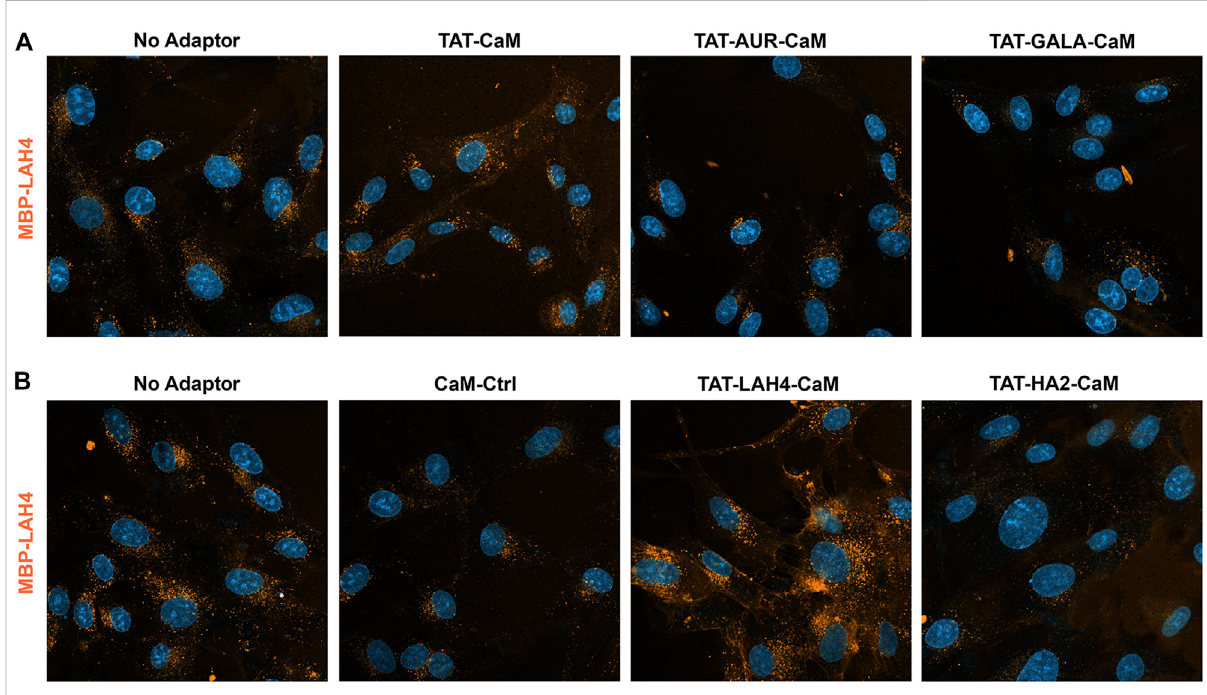
FIGURE 8 550-MBP-LAH4 internalized with adaptor set including controls as in the prior fi gure. Equimolar adaptor/cargo complexes (1 µM) were internalized in growth media for 1 h prior to washing (PBS x2) and imaging in media containing NucBlue. Internalization of MBP-LAH4 with adaptors asaboveinboththeupperpanel (A) andthelowerpanel (B) .Forpresentation, intensitieswithineachsetadjustedidenticallybutwiththeno-adaptor reference at approximately equal intensity for both